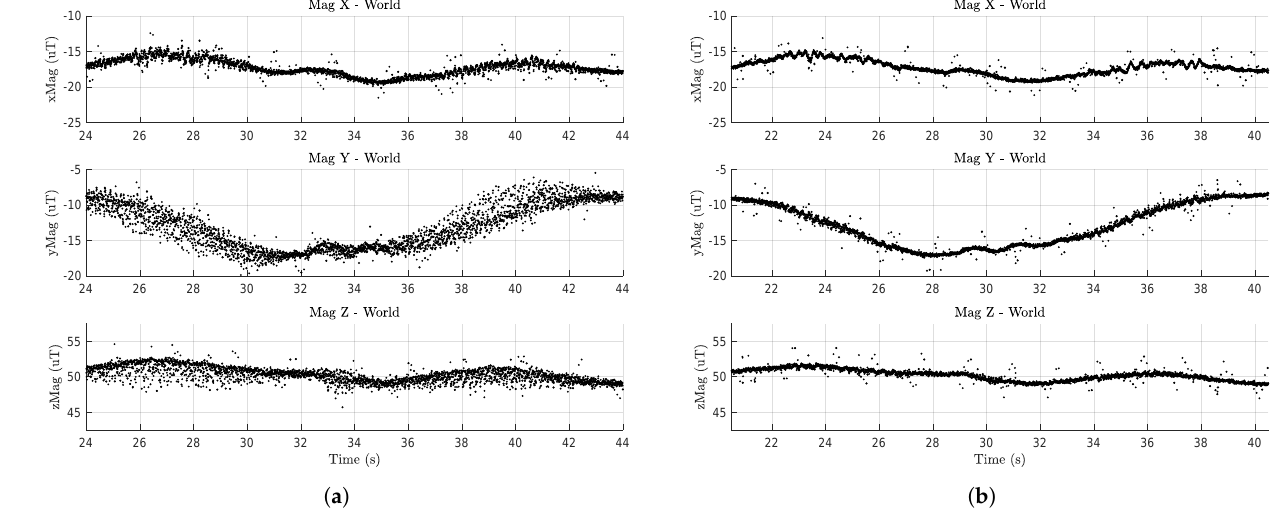
Figure 6. Vehicle “Maggie” flying two instances of the same flight trajectory, showing how the flight controller can inadvertently create noise in the measured magnetic field. ( a ) Test t5_00: Flight with “noisy” gains. ( b ) Test t5_01: Flight with “quiet”